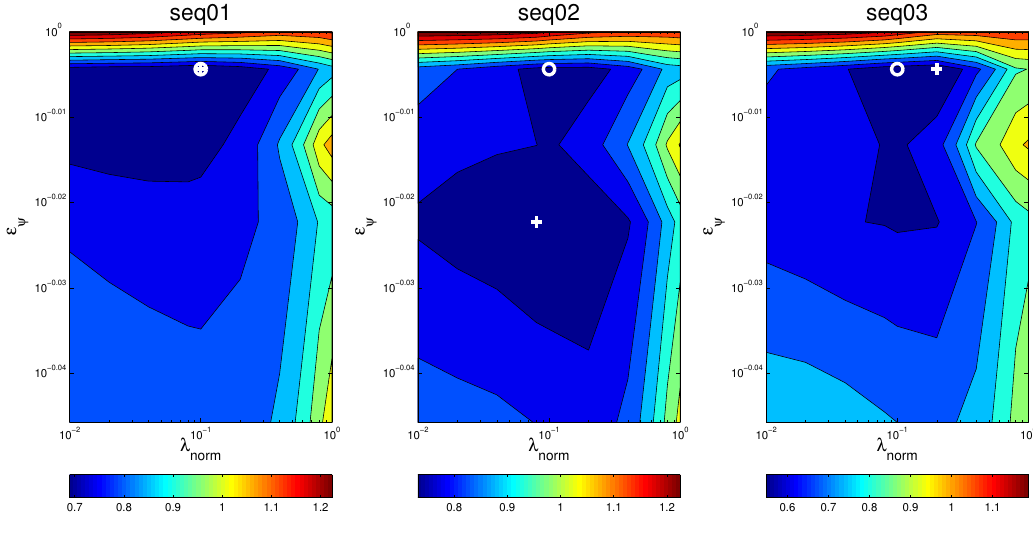
Figure 14. Optimization map for microphone setup B on all sequences, evaluating MOT P and frame size 160